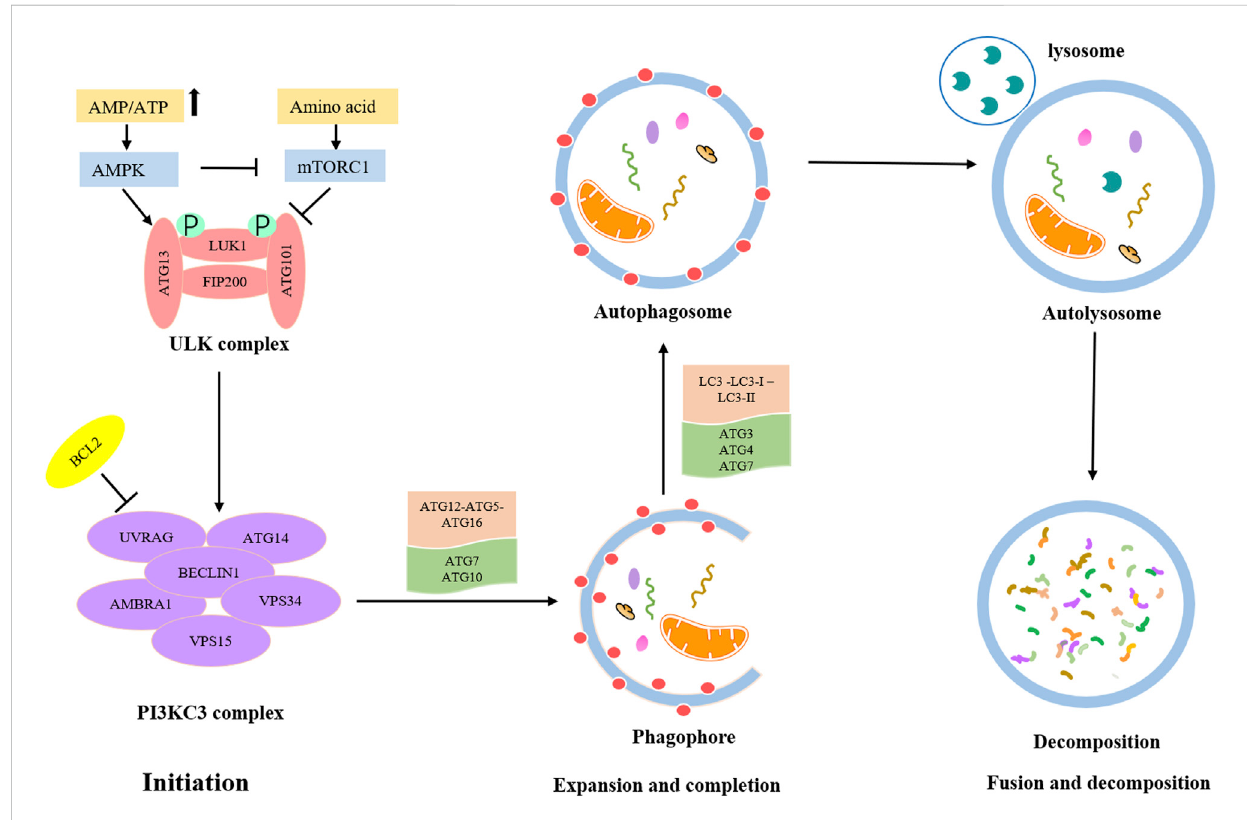
FIGURE 1 Overview of autophagy